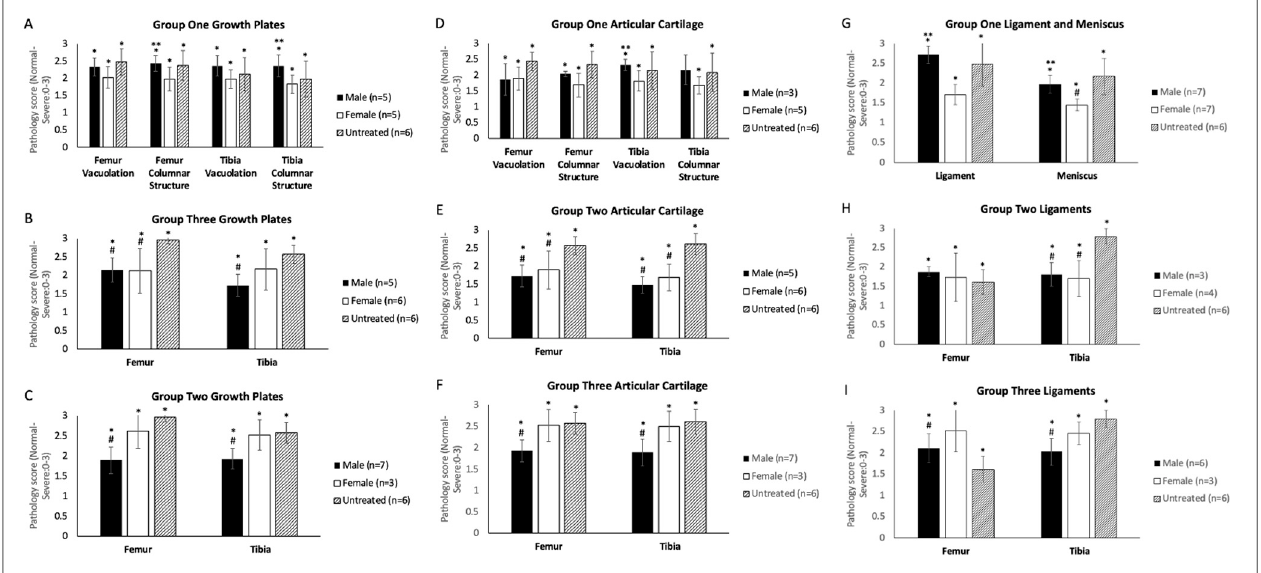
Figure 7. Histopathology severity ratings for ( A ) femoral and tibial growth plates of Group One (mice treated with the TBG promoter; 5 × 10 13 GC/kg body weight), ( B ) femoral and tibial growth plates of Group Two (mice treated with the CAG promoter; 5 × 10 13 GC/kg body weight), ( C ) femoral and tibial growth plates of Group Three (mice treated with the TBG promoter; 2 × 10 14 GC/kg body weight), ( D ) femoral and tibial articular cartilage of Group One (mice treated with the TBG promoter; 5 × 10 13 GC/kg body weight), ( E ) femoral and tibial articular cartilage of Group Two (mice treated with the CAG promoter; 5 × 10 13 GC/kg body weight), ( F ) femoral and tibial articular cartilage of Group Three (mice treated with the TBG promoter; 2 × 10 14 GC/kg body weight), ( G ) femoral ligament and meniscus of Group One (mice treated with the TBG promoter; 5 × 10 13 GC/kg body weight), ( H ) femoral and tibial ligaments of Group Two (mice treated with the CAG promoter; 5 × 10 13 GC/kg body weight), and ( I ) femoral and tibial ligaments of Group Three (mice treated with the TBG promoter; 2 × 10 14 GC/kg body weight). All WT severity scores were zero. * indicates a two-tailed t -test p -value of <0.05 compared to the WT cohort. ** indicates a two-tailed t -test p -value of <0.05 compared to the opposite sex. # indicates a two-tailed t -test p -value of <0.05 compared to the untreated cohort. TBG: thyroxine-binding globulin, CAG: a ubiquitous promoter including a cytomegalovirus enhancer element, a chicken β -actin promoter, and an intron.